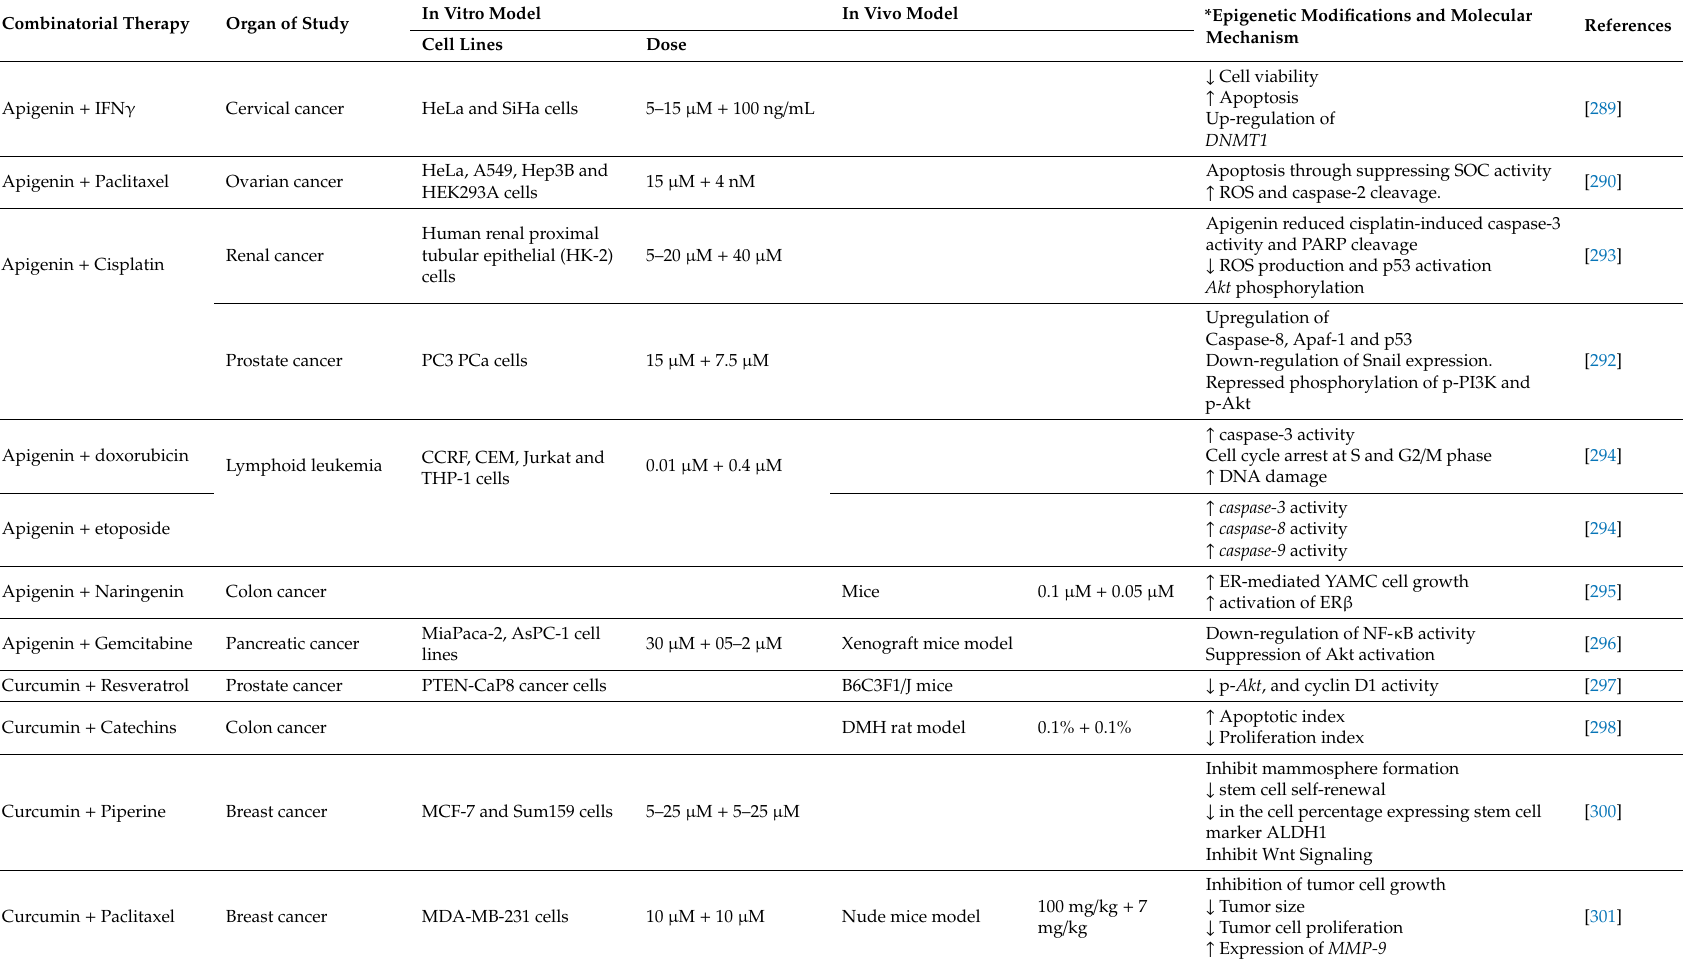
Table 3. Impact of combinatorial therapy (polyphenols, phytochemicals, and anti-cancer drugs) on epigenetic modifications and molecular mechanisms (in vivo and in vitro studies) in